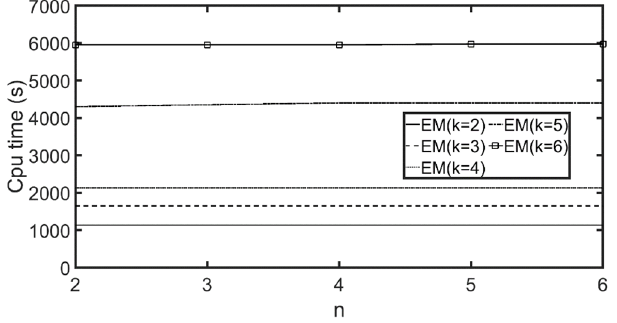
Figure 18. Computation time for customer similarity scores with ( α k = 4, α n = 4, NA).